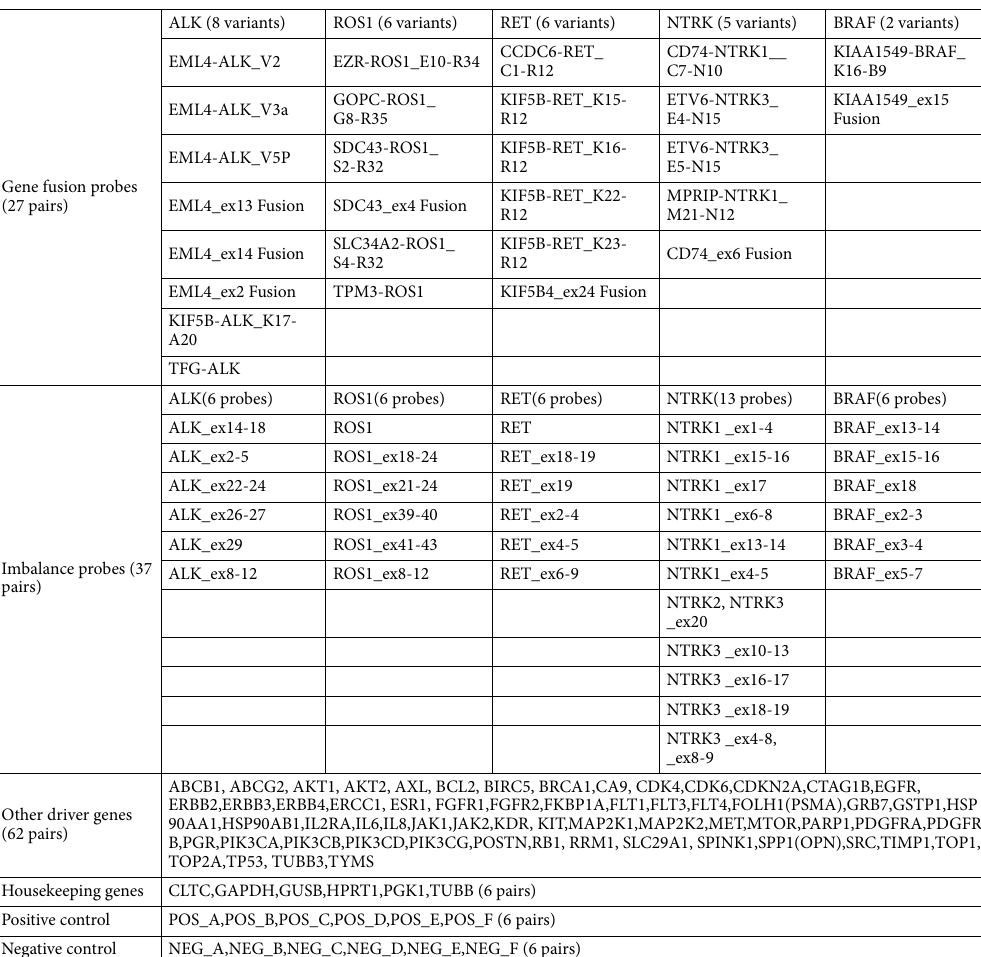
Table 1. Target-specific oligonucleotide probes designed for nCounter